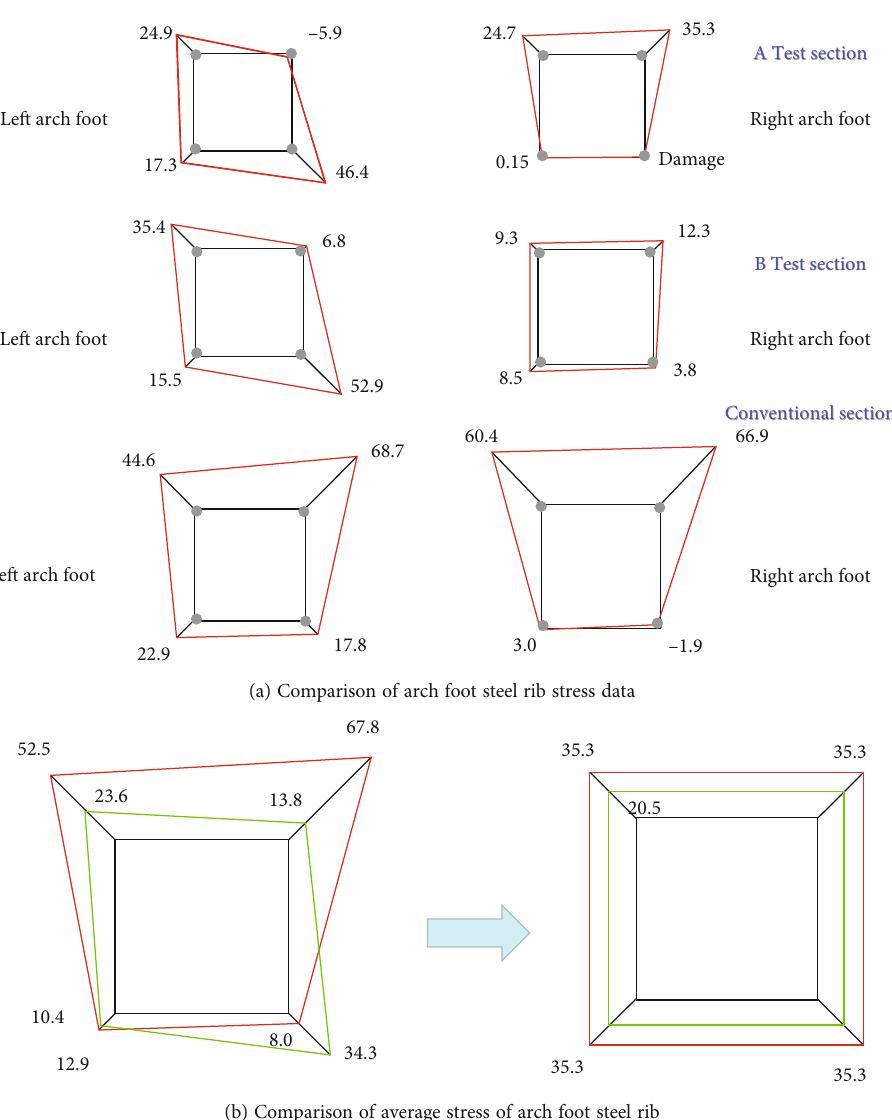
Figure 6: Comparison of data after stress stability of arch foot reinforcement in two monitoring sections (Unit: